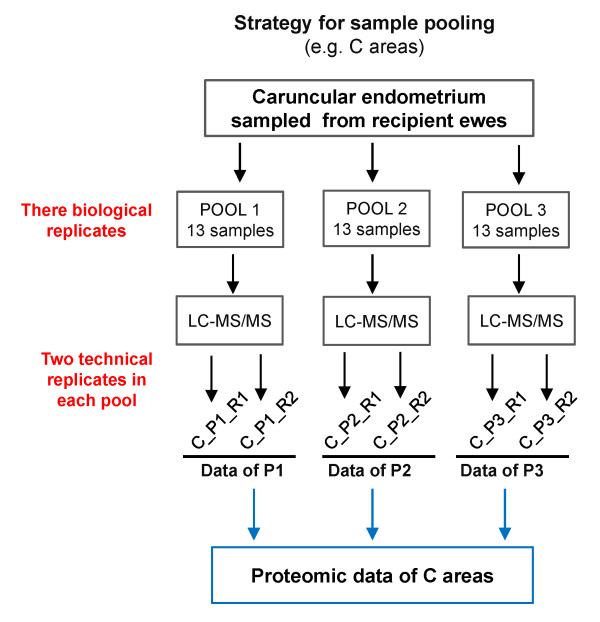
Experimental design of the study.